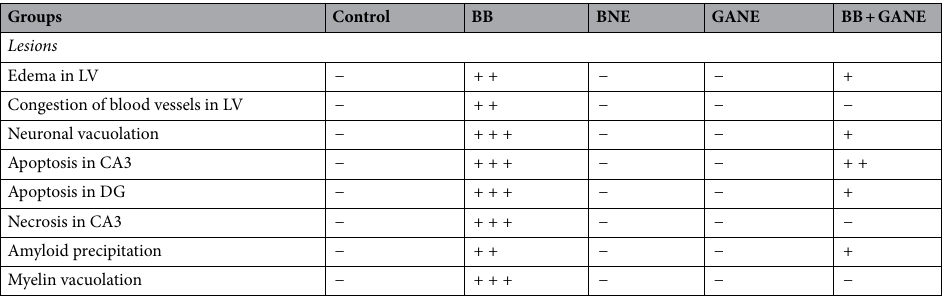
Table 2. The lesion scores of the histopathological results of the brain hippocampal region in all experimental groups. GA gum Arabic; BB bromobenzene; BNE blank nanoemulsion: GANE gum Arabic loaded ananoemulsion; BB + GANE bromobenzene + gum Arabic loaded nanoemulsion; LV lateral ventricle; CA3 Cornu ammonis3; DG dentate gyrus. − No lesions, + lesions present in 2–4 sections, + + lesions present in